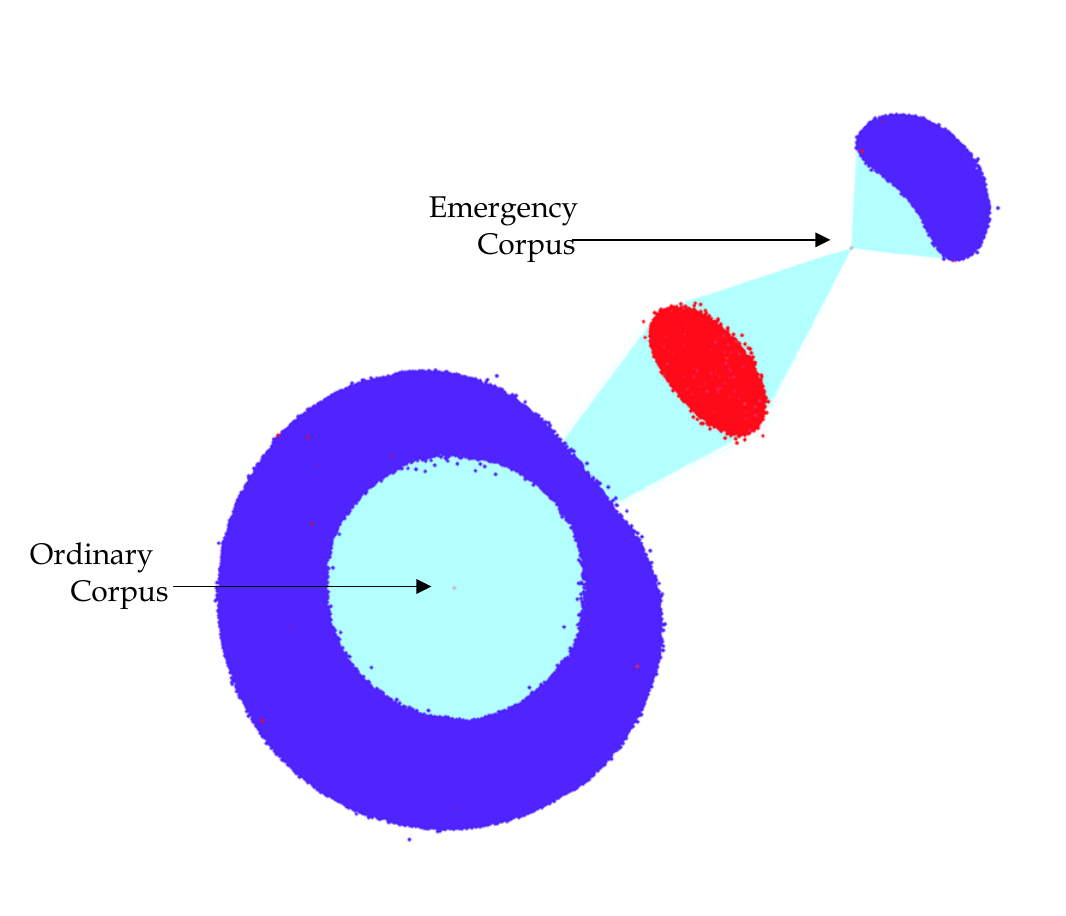
Figure 3: Network graph of all terms (ngrams of two to five words) which appeared at least 50 times in each of the corpuses, edges represent the link between term and corpus. The Grey nodes represent the two corpuses. Red nodes are common terms to both corpuses. Blue nodes appear in one corpus only. The network was visualized using ForceAtlas2 algorythm on